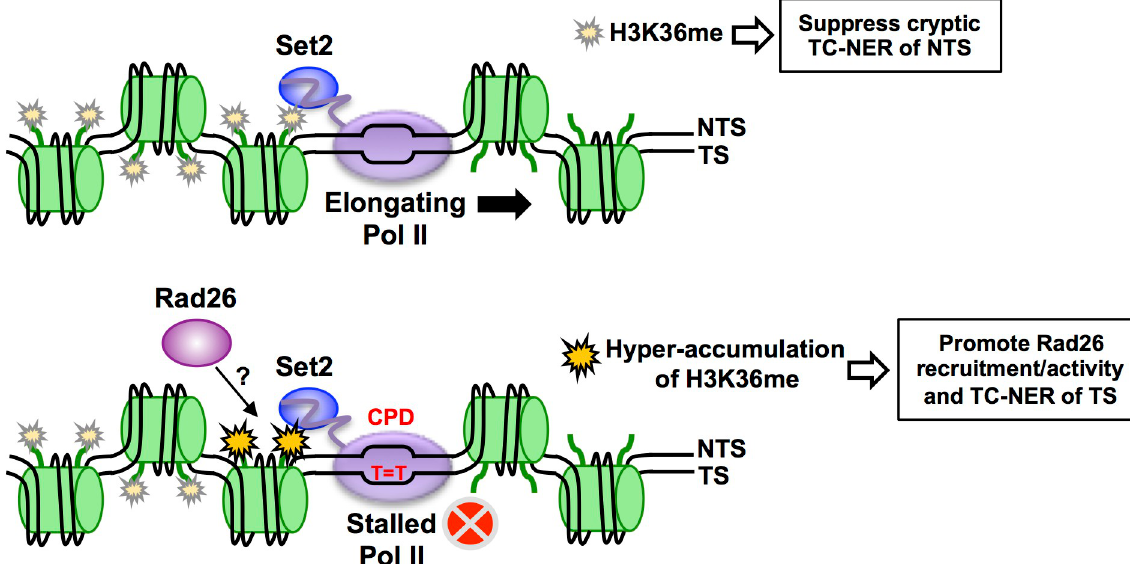
Fig 7. Model of how Set2 methylation may promote TC-NER of the TS and suppress cryptic TC-NER of the NTS. During normal Pol II elongation (top panel), co-transcriptional H3K36me by Set2 suppresses cryptic antisense transcription, thereby preventing cryptic TC-NER of the non-transcribed strand (NTS). When Pol II stalls at a CPD lesion (bottom panel), Set2-catalyzed H3K36me may accumulate immediately behind the stalled Pol II, thereby serving as an epigenetic signal of Pol II stalling. Hyper-accumulation of H3K36me may promote TC-NER of the transcribed strand (TS) by recruiting Rad26 behind the stalled Pol